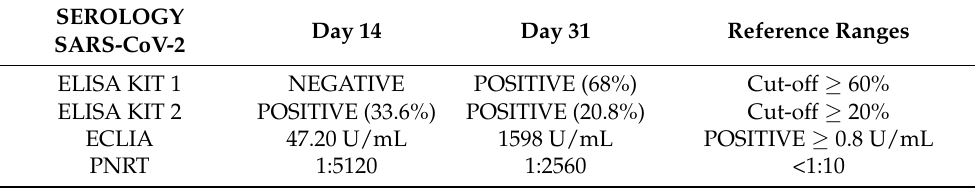
Table 5. Serological assays performed at different times: first cat’s blood sample collected 7 days after the beginning of the respiratory and gastrointestinal symptoms on Days 14 and